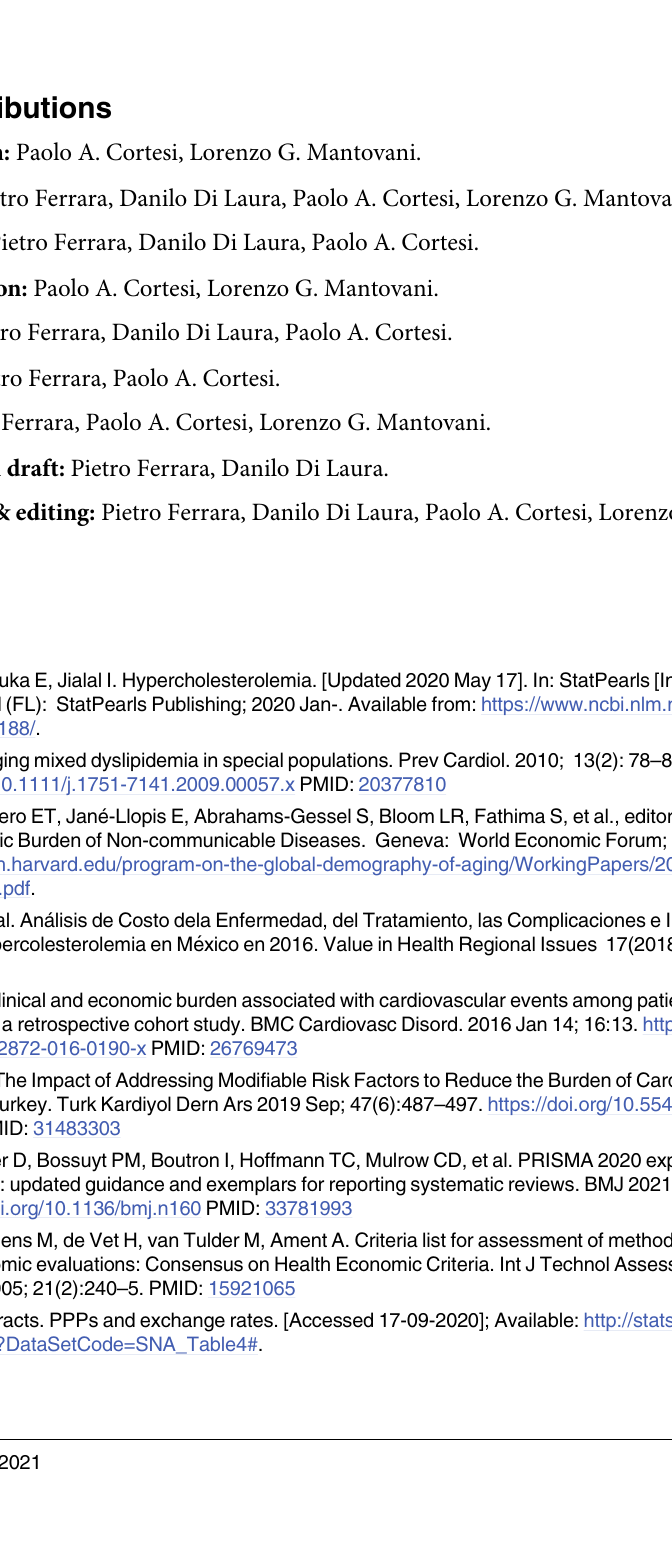
S2 Table. Population characteristics and clinical outcomes reported in the selected study. S3 Table. CHEC-list–assessment of the quality of the